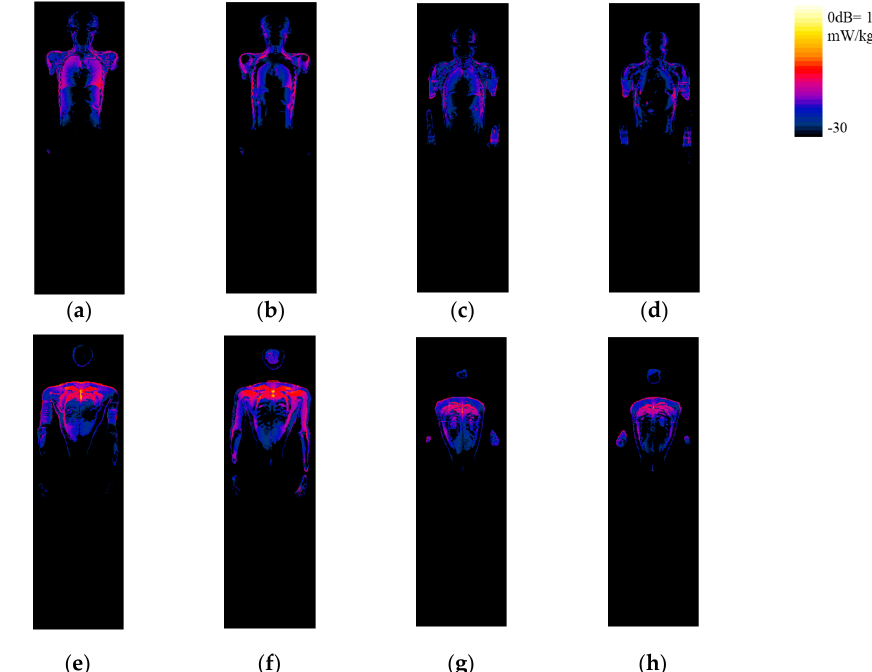
Figure 6. SAR results for the models at the standard position in the coil. ( a – d ) SAR distribution at the central coronal slice for the manually segmented Chinese adult male model, individual male model, manually segmented Chinese adult female model, and individual female model, respectively; ( e , f ) SAR distribution at the coronal slice which includes pSAR10g for the manually segmented Chinese adult male model, individual male model, manually segmented Chinese adult female model, and individual female model, respectively. The positions of pSAR10g are indicated in the figures. The results were normalized to a net incident power of 1 W.